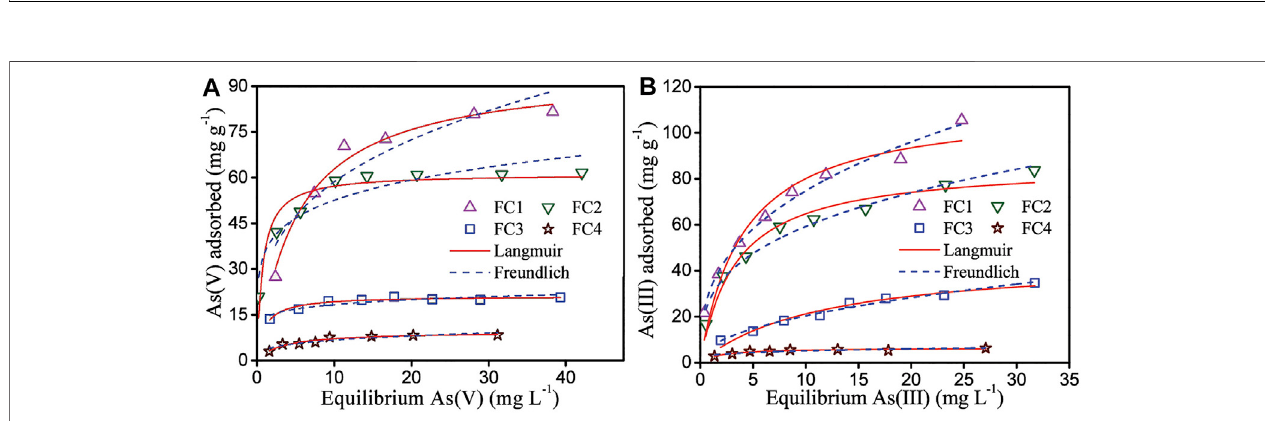
FIGURE 5 | Adsorption isotherm of (A) As (V) and (B) As (III) by Fe-Cu binary oxides. Initial arsenic concentration (cid:2) 2 – 60 mg/L, adsorbent dose (cid:2) 200 mg/L, pH (cid:2) 7.0 ± 0.1 and T (cid:2) 25 ± 1 ° C.